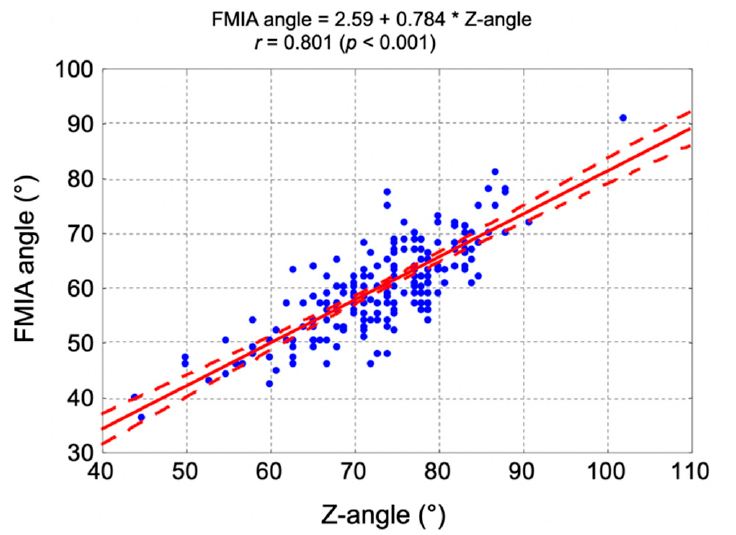
Figure 6. The correlation diagram between the Z-angle and FMIA angle, correlation coefficient, and regression straight-line equation. FMIA—Frankfort mandibular incisor plane angle. There was also a statistically significant negative correlation between the Z-angle and IMPA angle ( r = − 0.450, p < 0.001). Figure 7 presents the correlation diagram between the Z-angle and IMPA angle, correlation coefficient, and regression straight-line equation.